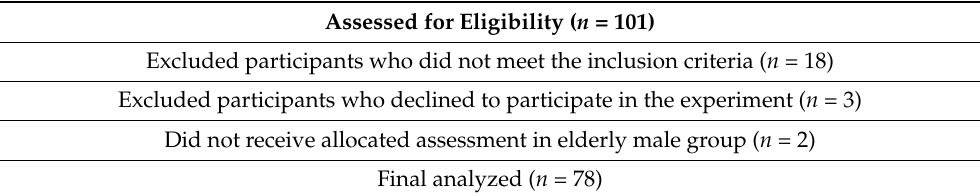
Table 1. Flowchart showing the experimental design of this study.